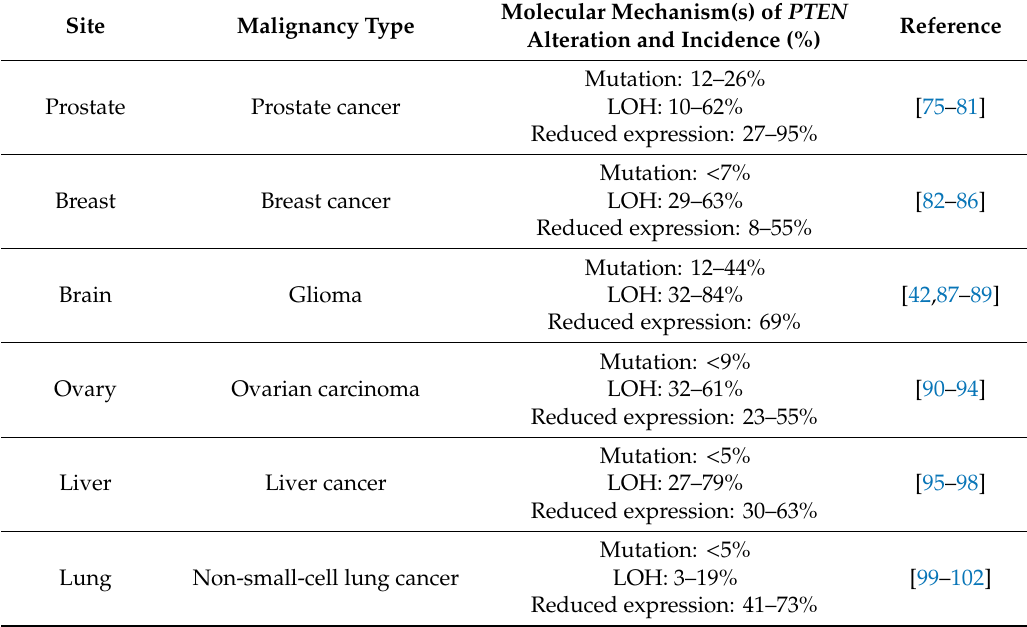
Table 1. Incidence of PTEN alterations in diverse malignancies. The type of alteration is specified along with the relative % of patients displaying that specific alteration. Studies with more than 30 patients were included in the